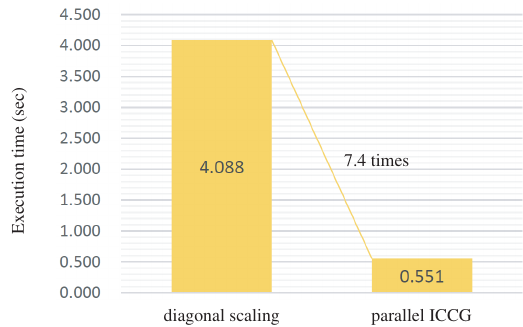
Figure 9. Execution time for the 201 × 201 mesh.